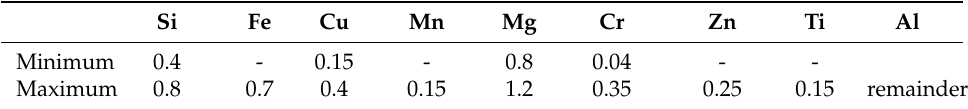
p and shoulder radius r s